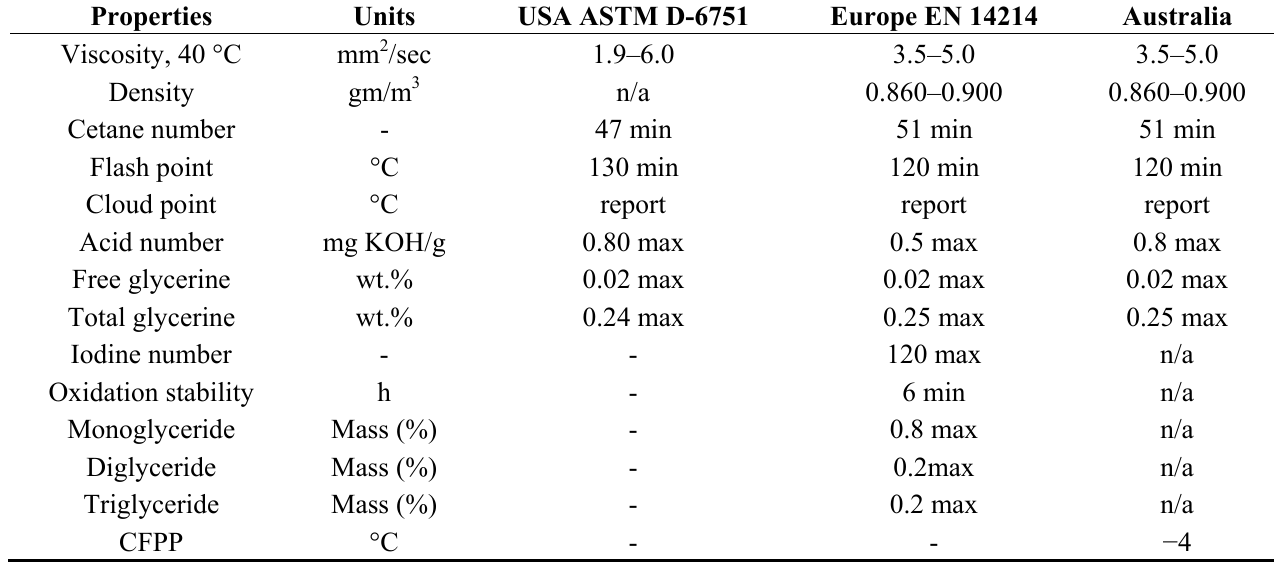
Table 5. International biodiesel standards